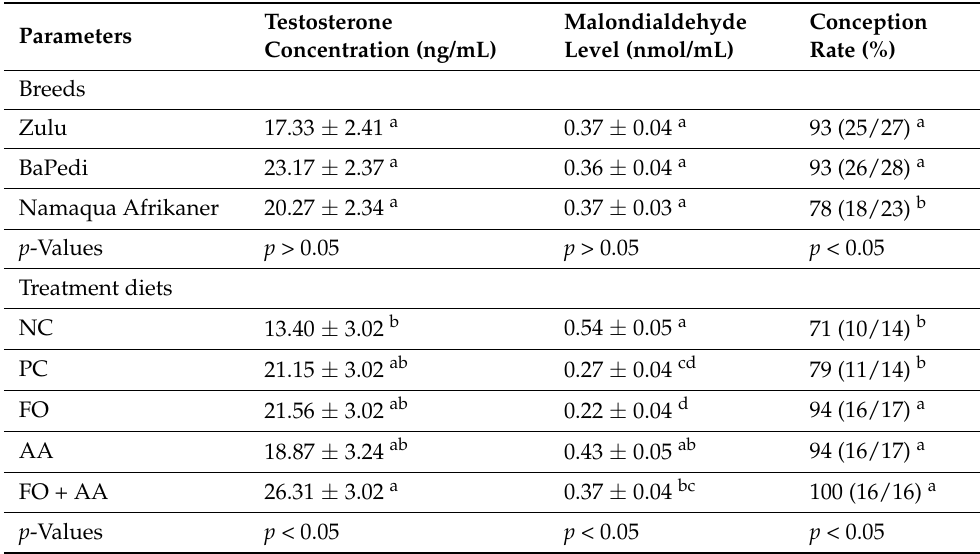
Table 6. Influence of breed and dietary treatments on testosterone